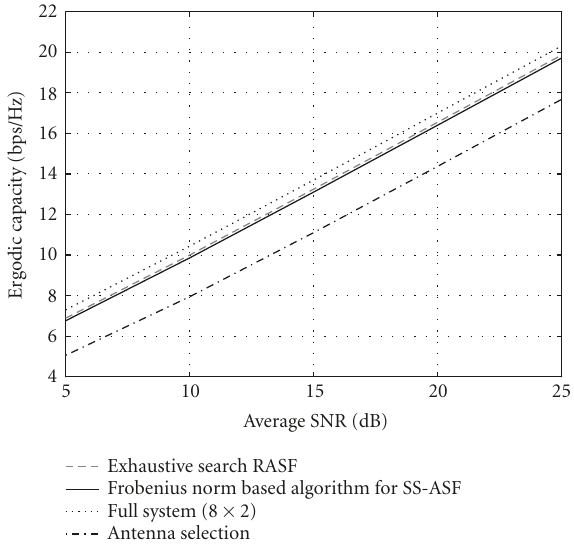
Figure 5: Performance evaluation of strictly structured ASF (SS- ASF) applied to an 8 × 2 MIMO Rayleigh i.i.d. channel, in terms of ergodic capacity. The performance of the algorithm is compared to the exhaustive search solution for receive ASF, the full system (8 × 2), and Gorokhov et al. decremental algorithm for antenna